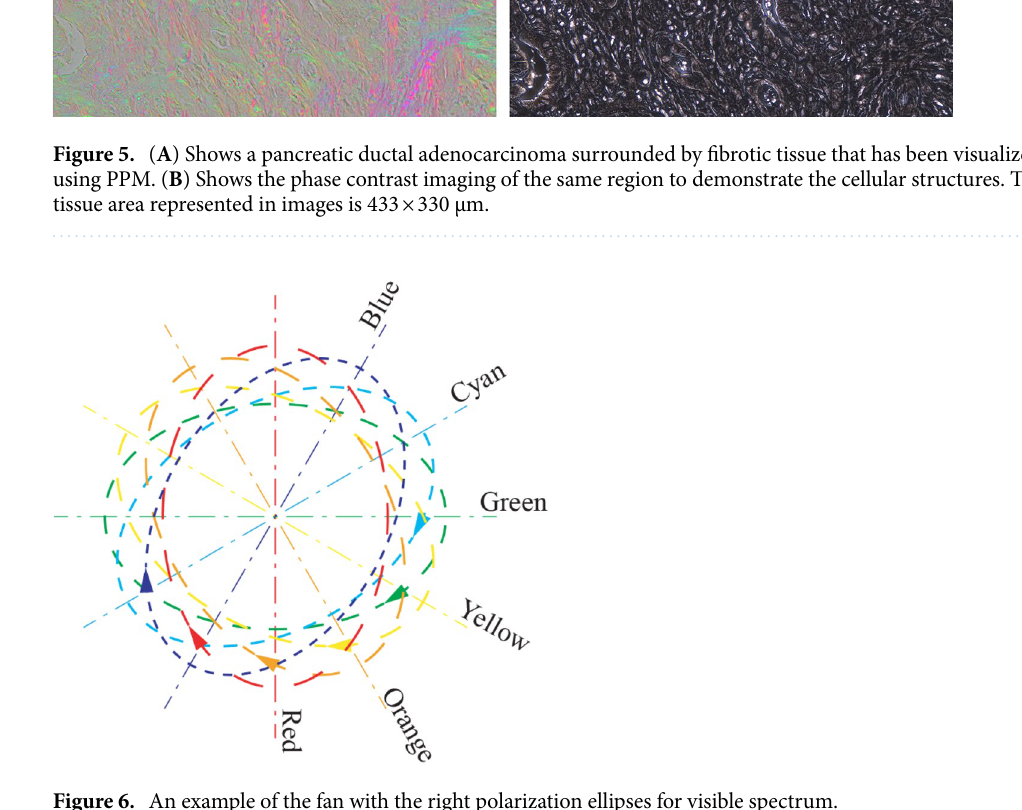
Figure 6. An example of the fan with the right polarization ellipses for visible